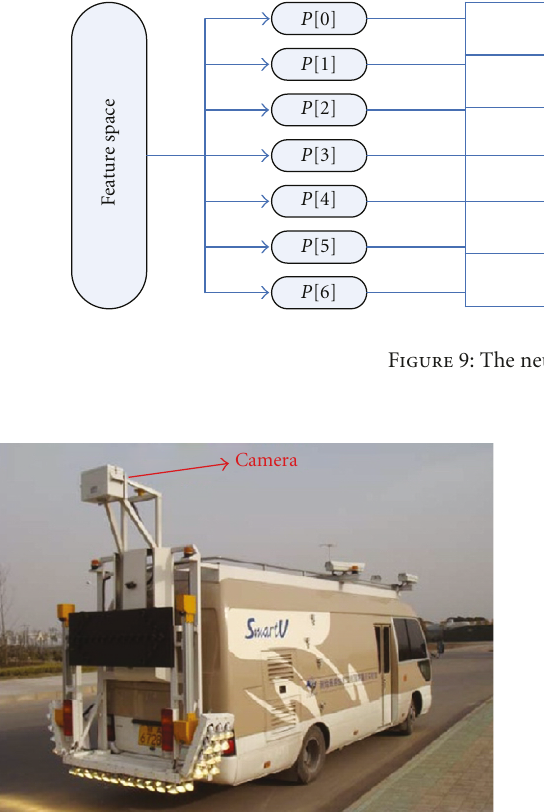
Figure 10: SmartV system.